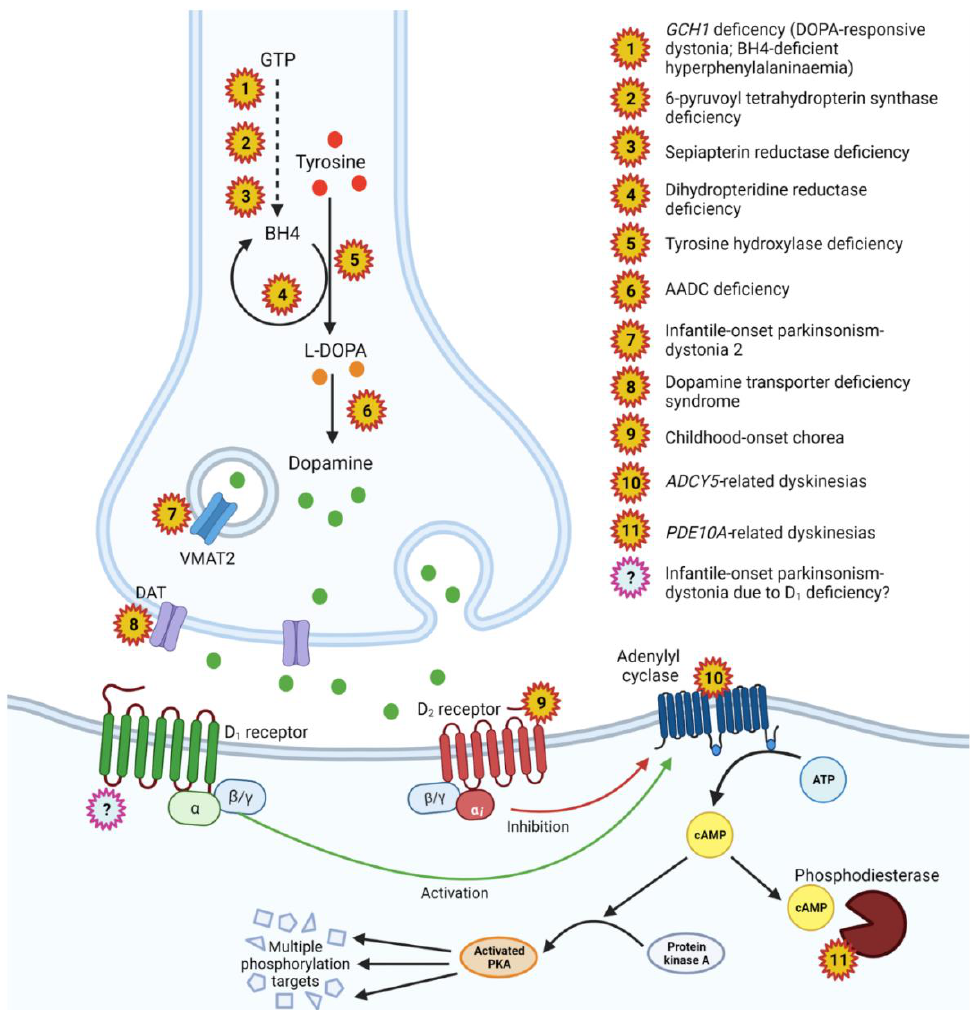
Figure 2. Dopamine pathway in the pre-synaptic dopaminergic neuron: key enzymes, proteins and associated diseases. Schematic representation of a dopaminergic synapse. Dopamine is synthesised from tyrosine in the presynaptic cell: tyrosine is converted to L-dopa by tyrosine hydroxylase, with tetrahydrobiopterin as a cofactor, then L-dopa is decarboxylated to dopamine by aromatic l-amino acid decarboxylase (AADC). Dopamine is packaged into presynaptic vesicles by the vesicular monoamine transporter 2 (VMAT2), before being released into the synapse. On the post-synaptic membrane, dopamine binds D 1 -like and D 2 -like receptors, causing the activation or inhibition of adenylyl cyclase, leading to increase or decrease of intracellular cAMP and downstream signalling pathways mediated by protein kinase A. Stars indicate genetic diseases associated with defects in these